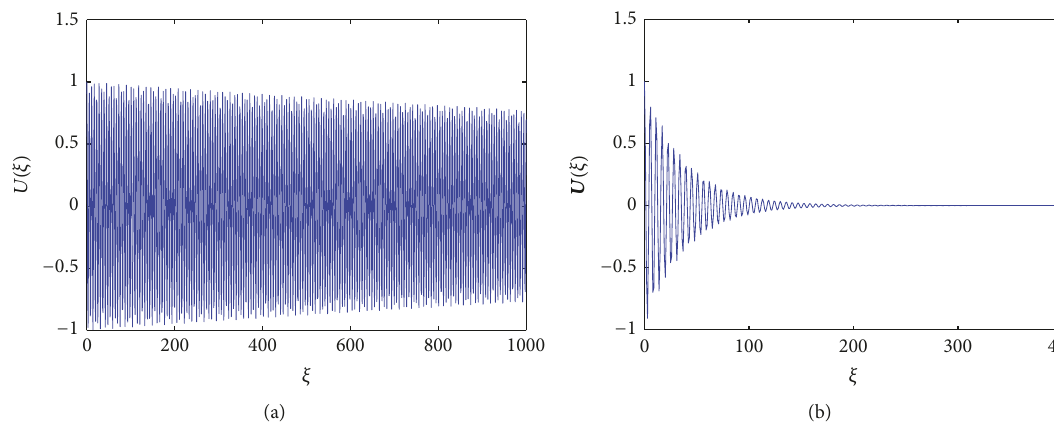
Figure 12: The curve of 𝑈(𝜉) at the temperature 𝑇 = 293𝐾 for perturbation parameters (a) 𝜀 = 10 −8 and (b) 𝜀 = 10 −7 .